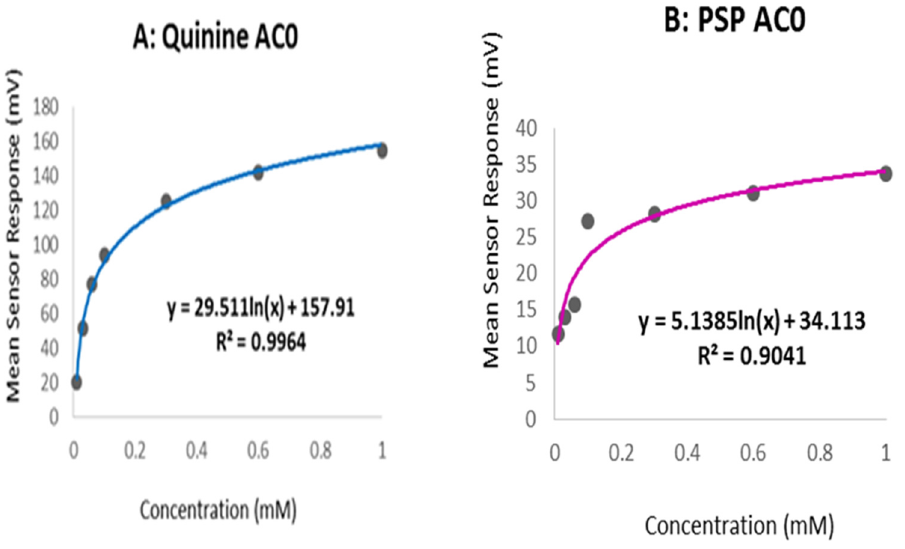
Figure 9. AC0 logarithmic trend-line response curve for ( A ) quinine HCl dihydrate and ( B ) PSP.